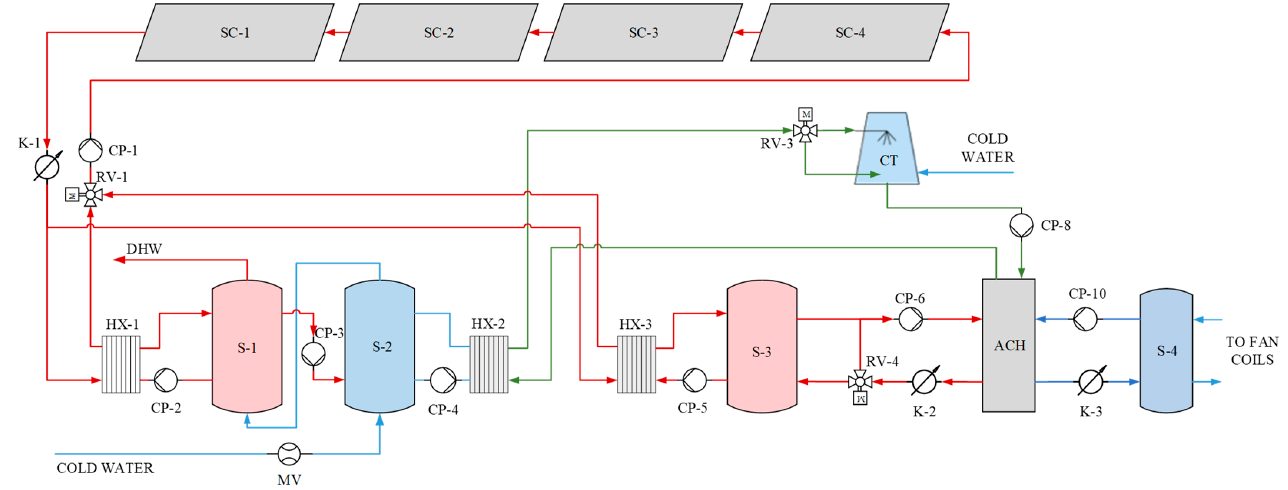
Figure 6. S-FO-ACH-1/S-NG-ACH-1—solar DHW heating and absorption space cooling system lay- out.